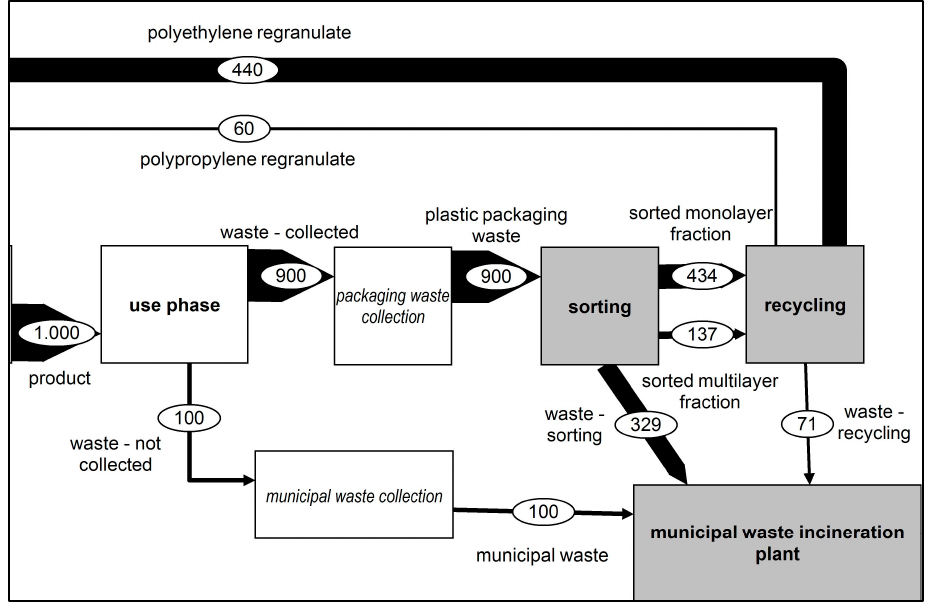
Figure 7. Representation of the material flows—2025 scenario.